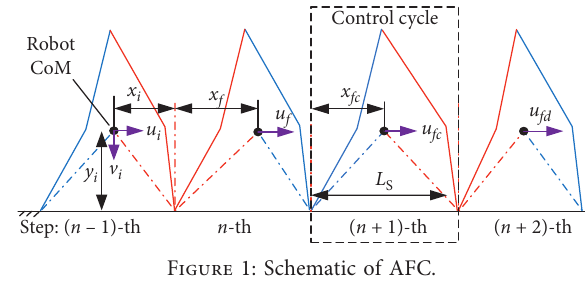
Figure 1: Schematic of